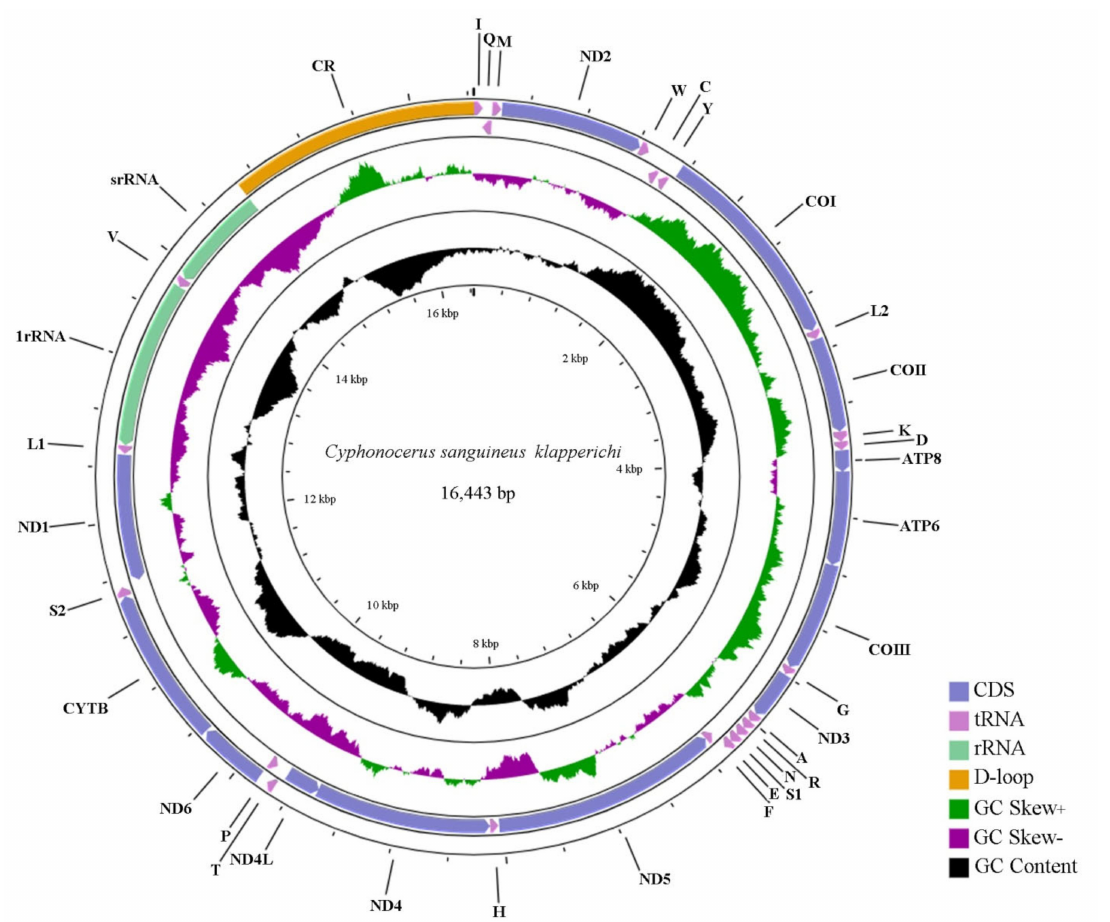
Figure 1. Circle map of the complete mitogenome of C. sanguineus klapperichi . Different colors indicate different types of genes and regions. Genes shown at the outer circle are located on the J-strand, and those at the inner circle are located at the